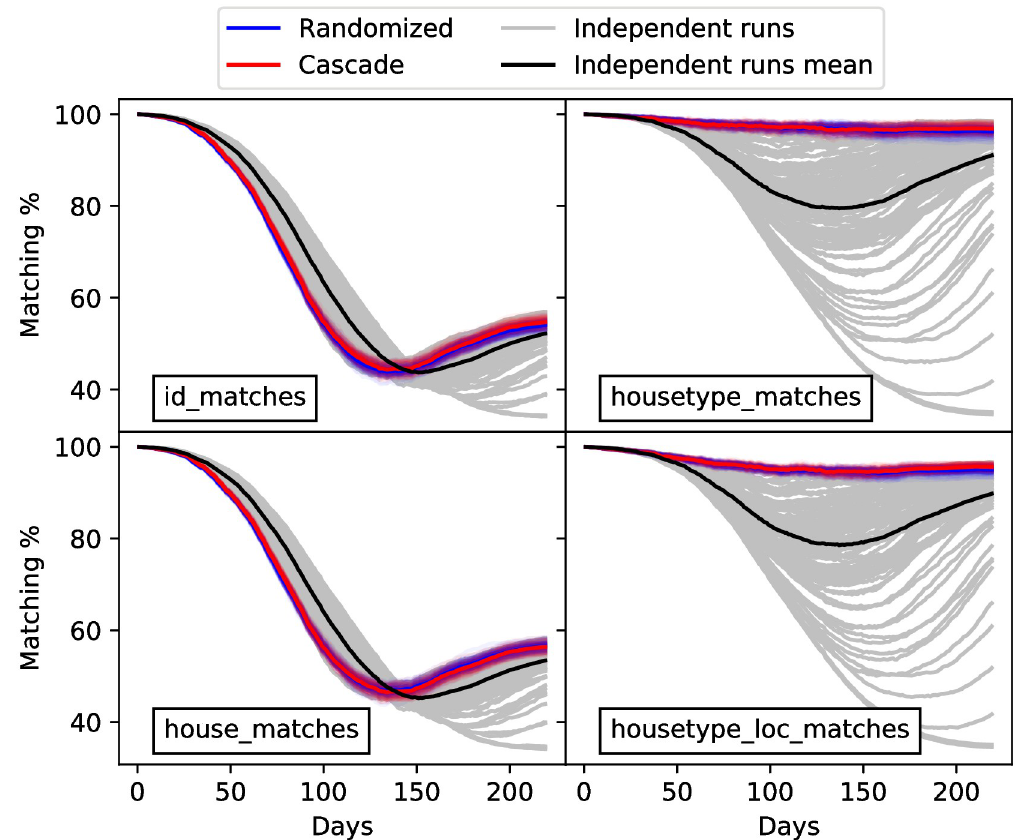
Fig 6. Evolution of matching metrics over time. The evolution of the id_matches, housetype_matches, house_matches and housetype_loc_matches to the true state are shown from left to right and top to bottom panels. For every panel, the gray lines represent the metrics for the control simulations and their mean is drawn with a black line. Red (blue) transparent lines correspond to EnKF estimation with the randomized (cascade) agent adjustment method. Semitransparent lines represent the ensemble members while their mean is drawn with a solid line of the corresponding